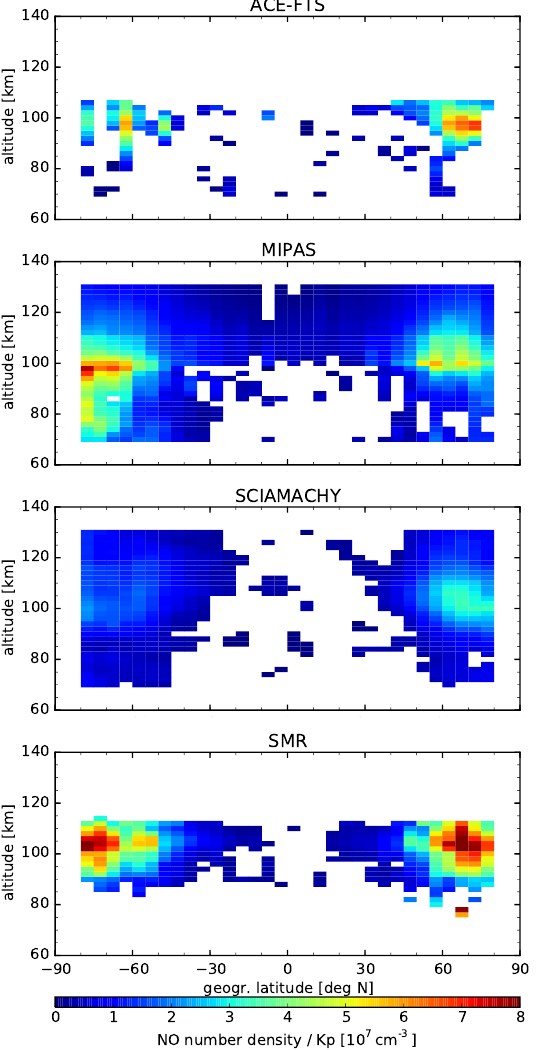
Figure 19. NO regression coefficient c of the short-term geomag- netic variations from the Kp index as in Fig. 16.